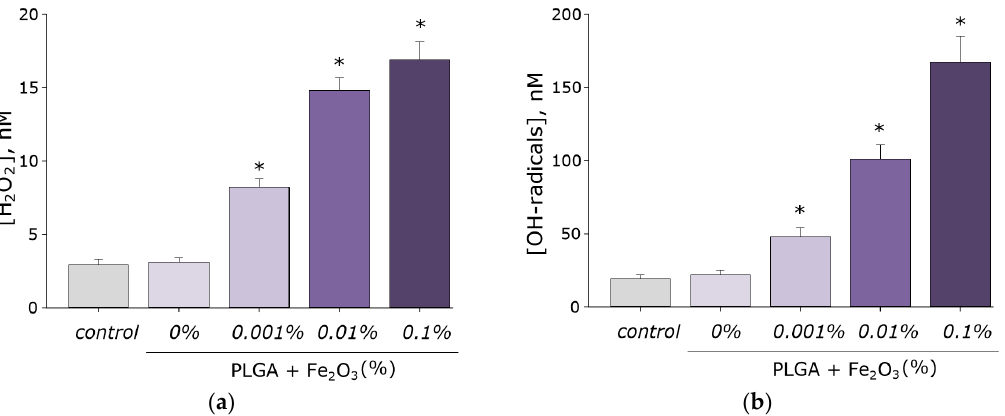
Figure 6. Effect of a PGLA ‐ based material with iron oxide nanoparticles on the generation of ROS in aqueous solutions: hydrogen peroxide ( a ), hydroxyl radicals ( b ). *—statistically significant differences compared with the control group ( p < 0.05). Data are presented as mean ± standard error of the